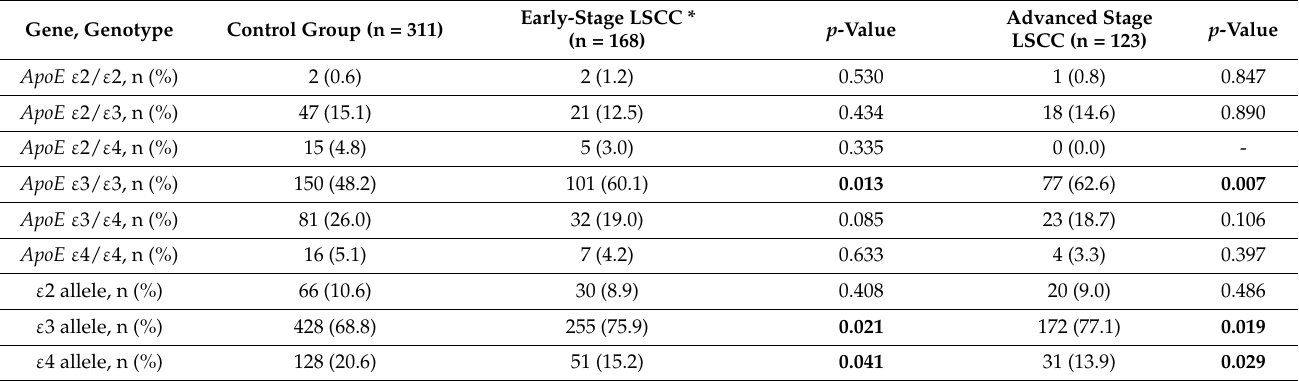
Table 4. Distribution of ApoE genotypes and alleles frequencies between the control and patients with LSCC (in early and advanced stages) groups.